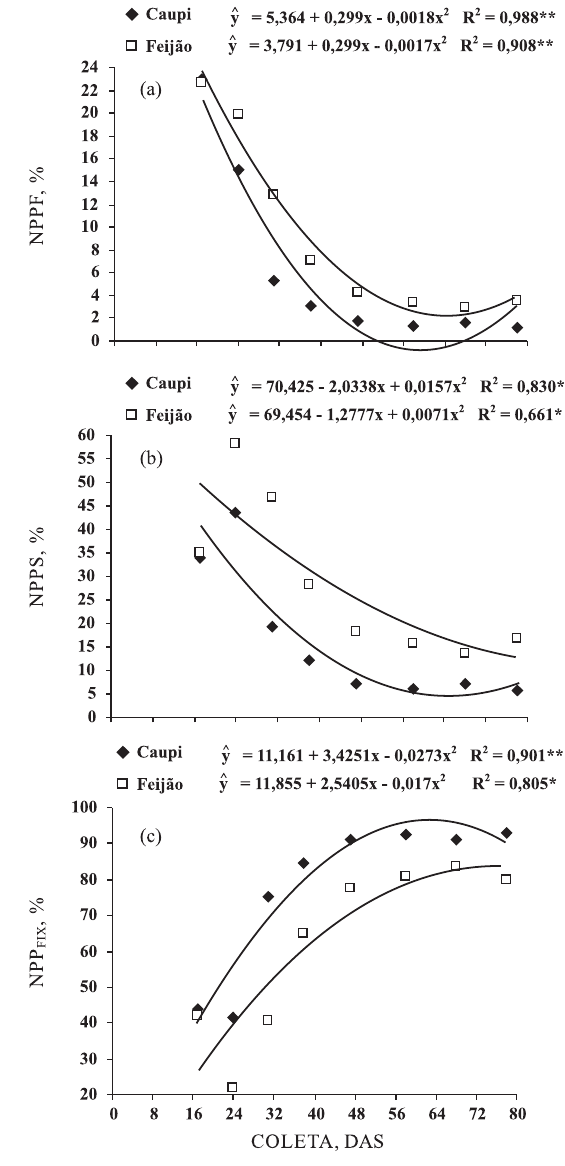
Figura 3. Percentagem de nitrogênio proveniente do fertilizante (NPPF) (a), do solo (NPPS) (b) e da fixação simbiótica (NPPfix) (c) na parte aérea (caule + ramos + folhas + pedúnculos e vagens) do feijão-comum e feijão-caupi, em função de diferentes épocas de coleta. ** e *: significativo a 1 e 5 %,